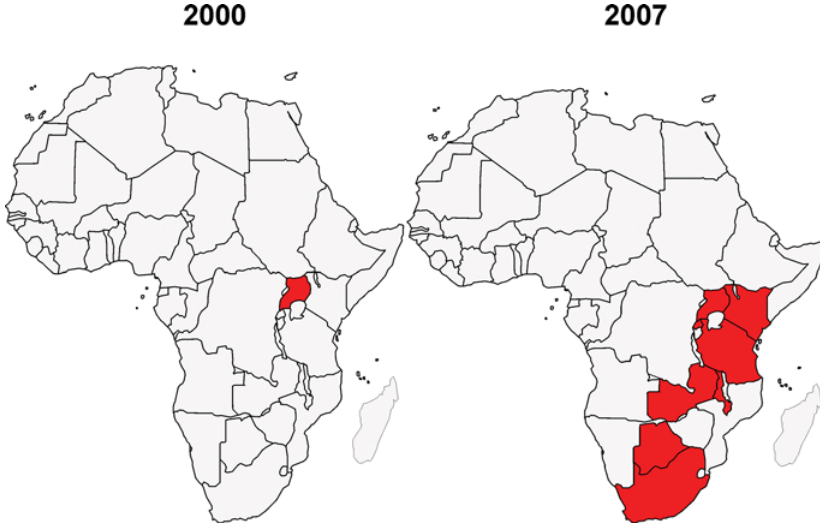
Figure 3. African Countries Participating in HIV Vaccine